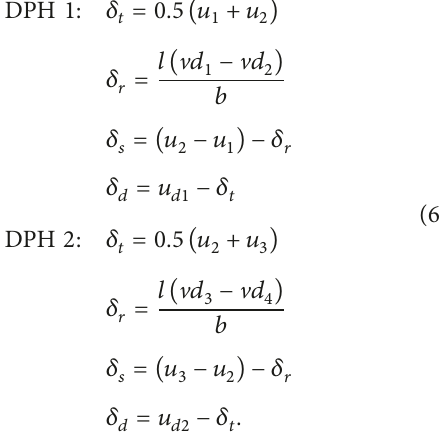
Figure 5: Takeda thin hysteresis rule